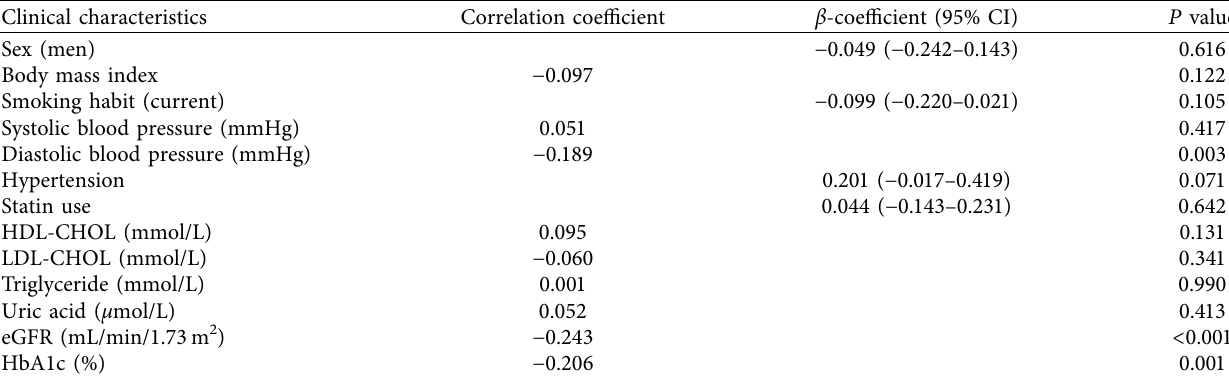
Table 2: Associations between clinical characteristics and FIB4 index.